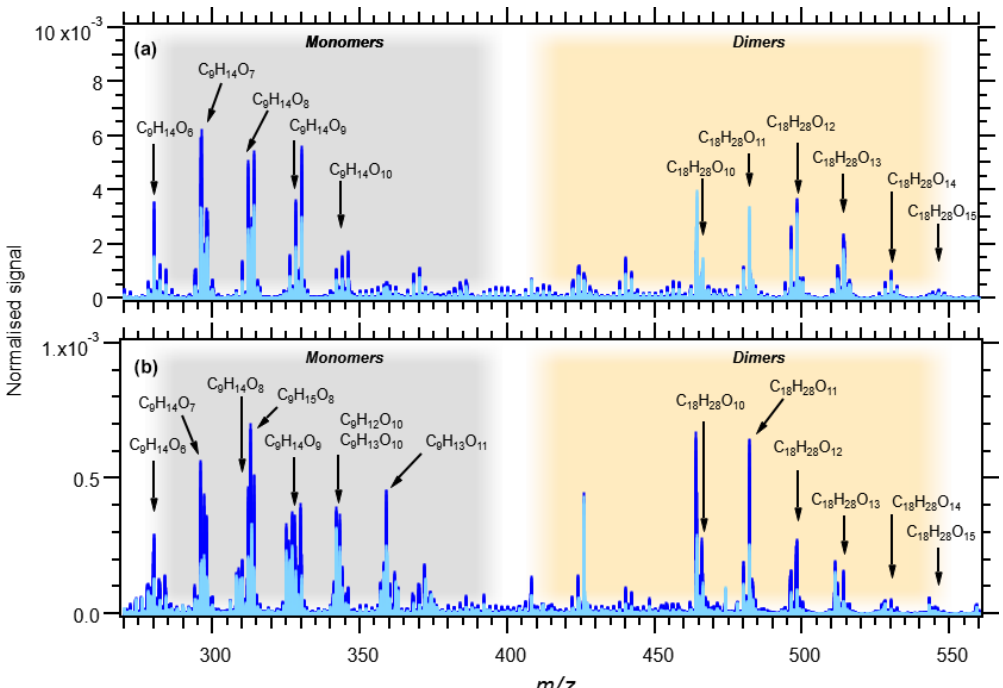
Figure 3. Mass spectra of all experiments without NO x : 1–4. Panel (a) shows experiments 3 (light blue) and 4 (blue) with OH exposure of 2 . 87 × 10 11 and 3 . 47 × 10 11 molecscm − 3 , respectively. Panel (b) shows experiments 1 (light blue) and 2 (blue) with OH exposure of 3 . 47 × 10 10 and 7 . 62 × 10 10 molecscm − 3 , respectively. The signal at m/z 426 is associated with the mass calibration using perfluoroheptanoic acid (PFHA). Note the 10 times lower normalised signal scale in (b) . Table 2. Contribution of oxidation product families to the total signal between m/z 270 and 560.